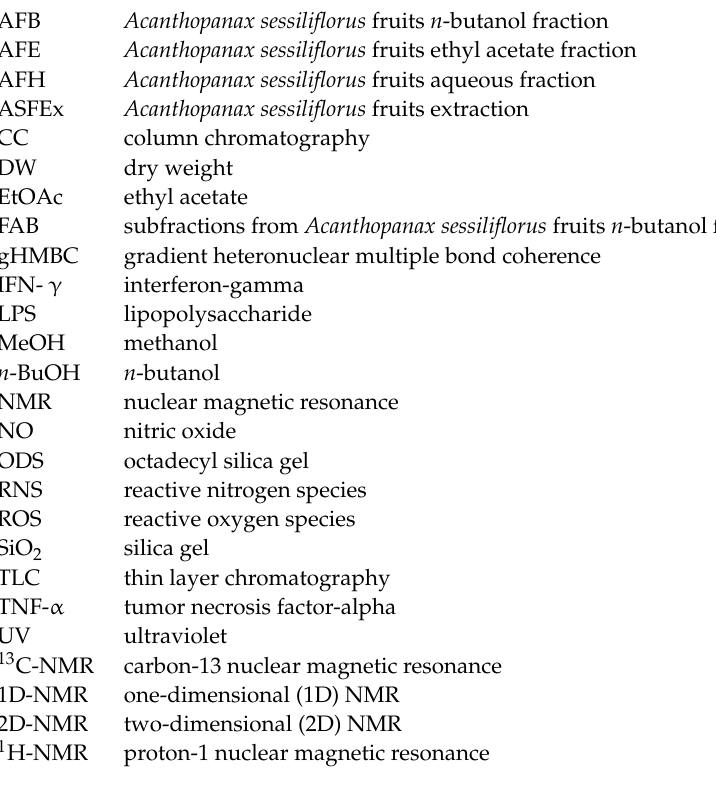
Acanthosessilioside L. Figure S7: 1H, 13C NMR, Qtrap/MSMS, and HRESIMS of Acanthosessilioside M. Figure S8: 1H, 13C NMR, Qtrap/MSMS, and HRESIMS of Acanthosessilioside N. Figure S9: 1H, 13C NMR, Qtrap/MSMS, and HRESIMS of Acanthosessilioside